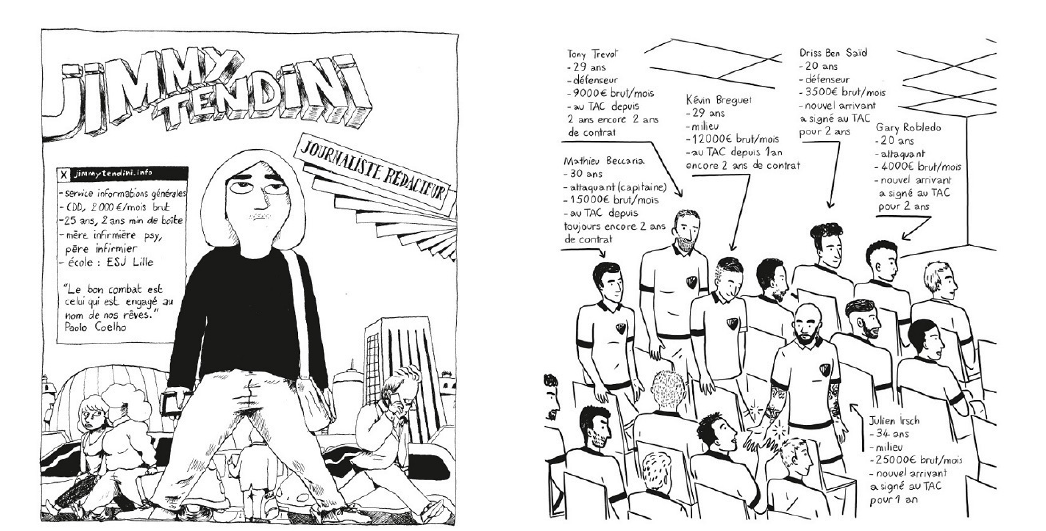
Figure 5: La banlieue du 20 heures, Berthaut/Helkarava ©CASTERMAN (left); L’amour du Maillot, Rasera/Georges ©CASTERMAN